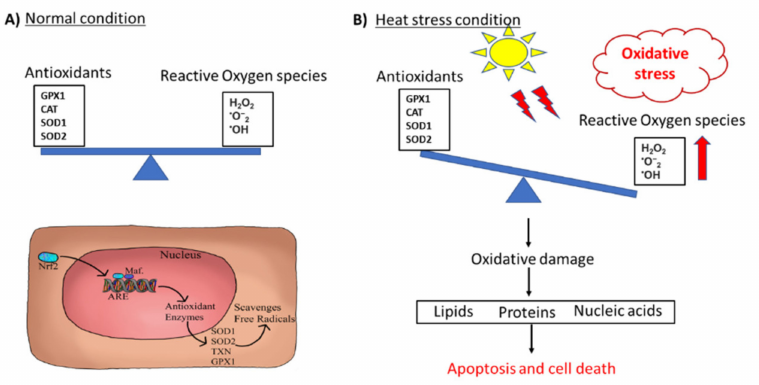
Figure 2. Schematic diagram showing the redox system. ( A ) Normal condition, and ( B ) under heat stress.